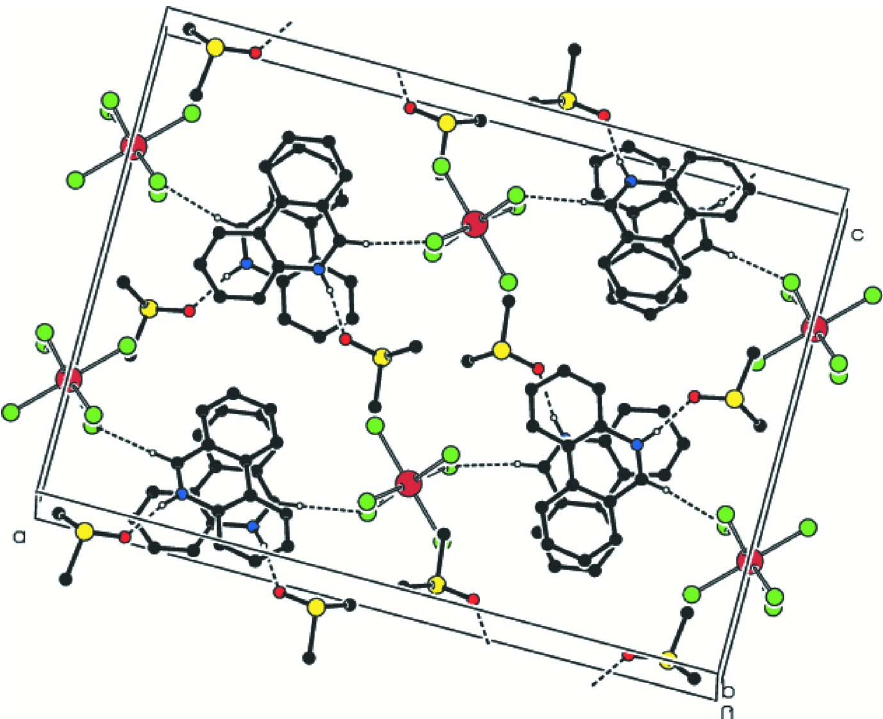
View of the packing and hydrogen bonding interactions. For clarity, H atoms not involved in hydrogen bonds have been